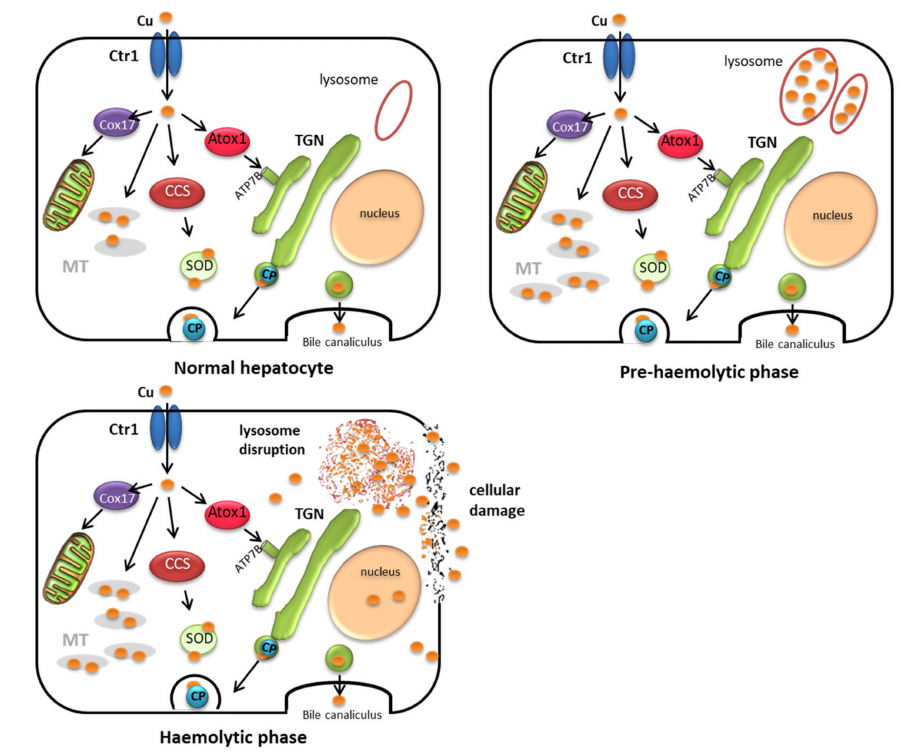
Figure 4. Phases of copper accumulation in the hepatocyte. Ctr1: Copper specific transporter; DMT1: Divalent Metal Transporter 1; MT: Metallothionein; TGN: Trans Golgi Network; Cox17 and Atox1: Copper chaperone proteins; SOD: Superoxide dismutase; CP: Ceruloplasmin; CCS: Cytochrome c oxidase; ATP7B: Copper-transporting P-type